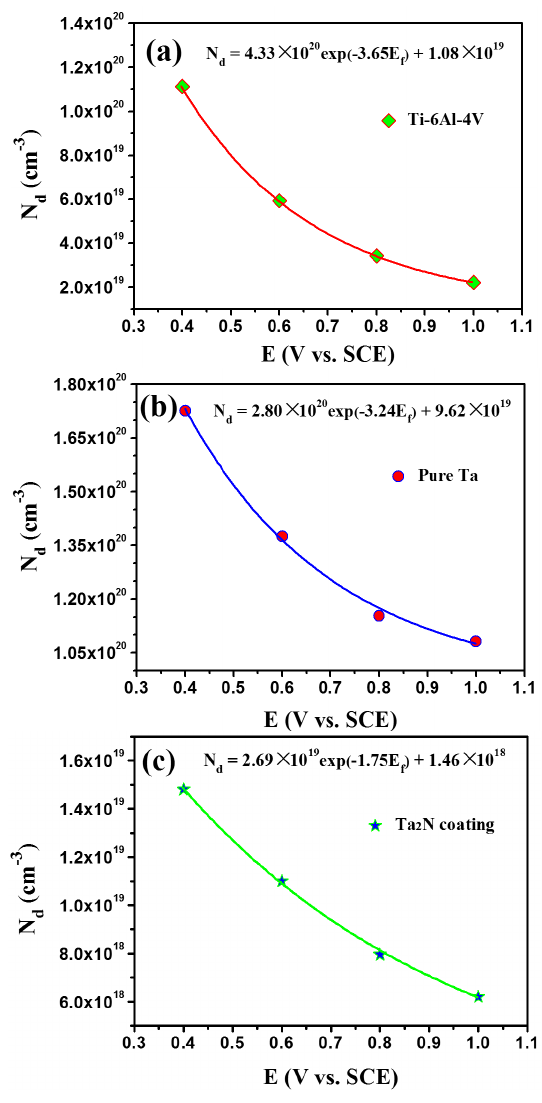
Figure 14. Donor density ( N d ) in the passive films formed on ( a ) uncoated Ti-6Al-4V; ( b ) commercially pure Ta and ( c ) the Ta 2 N coating in Ringer’s physiological solution as a function of film formation potential ( E f ). The solid lines are the exponential fit of N d on E f . In order to obtain the value of ω 2 , the dependence of N d on E f was fitted using a first-order exponential decay function [46,50,57]: